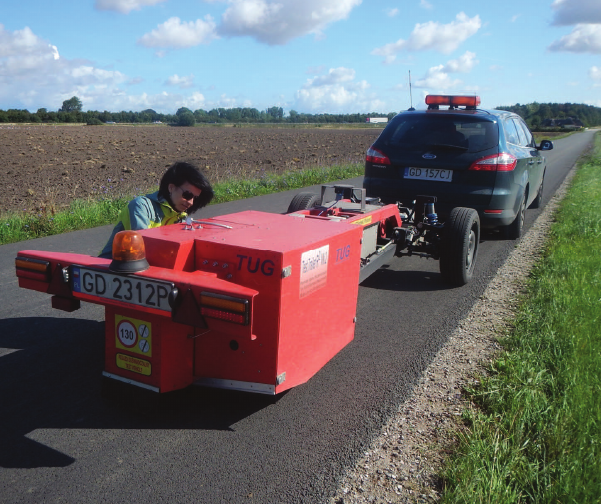
Fig. 5. Test trailer R2 Mk.2 built by the Technical University of Gda ń sk